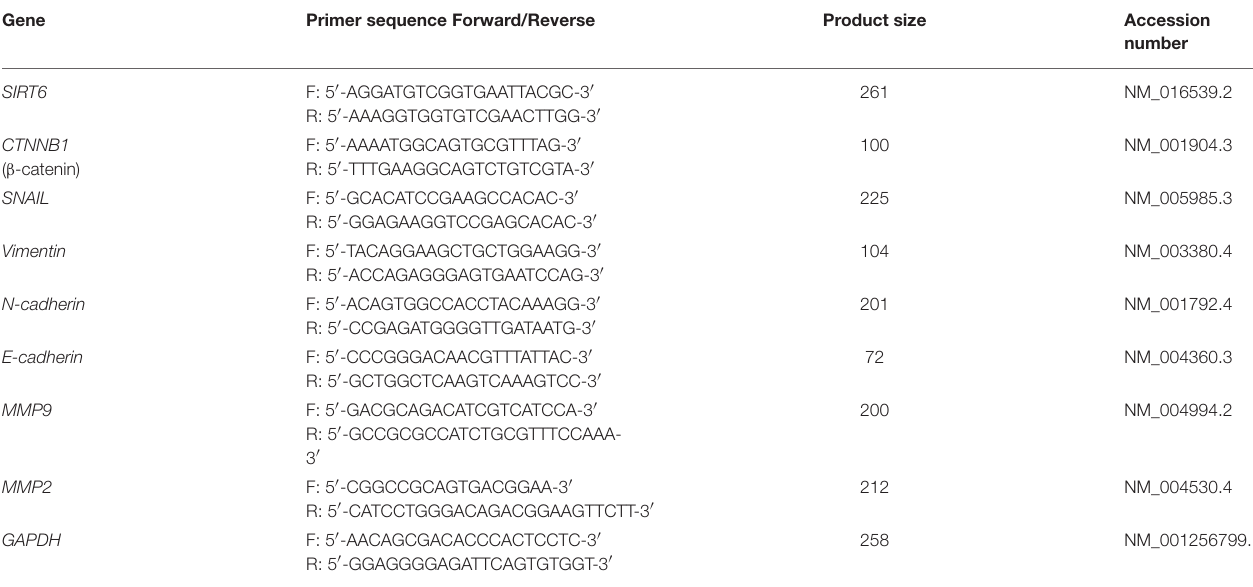
TABLE 1 | Primer sequences used for quantitative real-time polymerase chain reaction. Gene Primer sequence